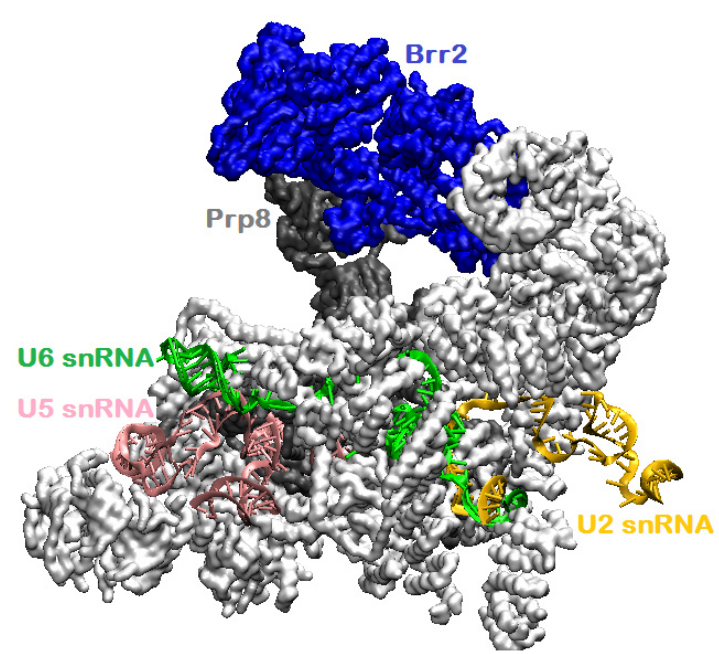
Figure 4. Yeast-activated (B act ) spliceosome 79 (PDB ID 5LQW; cryo-electron microscopy [cryo-EM] 5.8Å). Brr2 has separated U4 and U6 small nuclear RNAs (snRNAs), and U4 small nuclear ribonucleoprotein particle (snRNP) has been expelled from the spliceosome. Brr2 is bound to the Jab1 domain of Prp8. All 27 proteins are shown in surface representation; most are colored white. Visualized with visual molecular dynamics